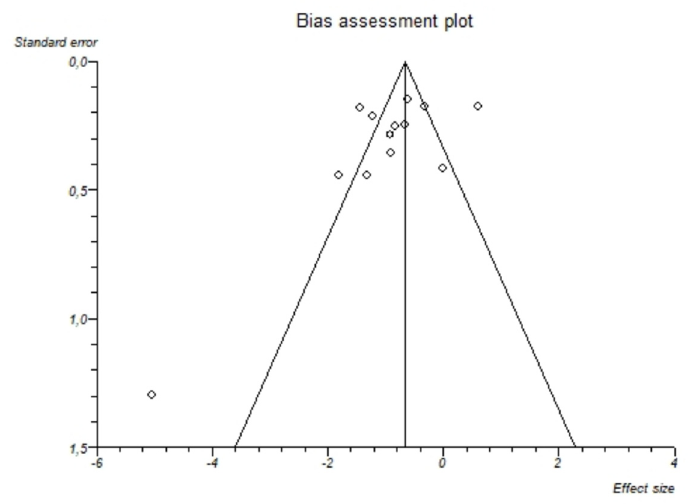
Figure 3. Bias assessment plot (funnel plot) about the pooled mean difference of magnesemia between alcohol group and controls. The visual analysis does not show a significant asymmetry and the presence of a publication bias is not demonstrated.